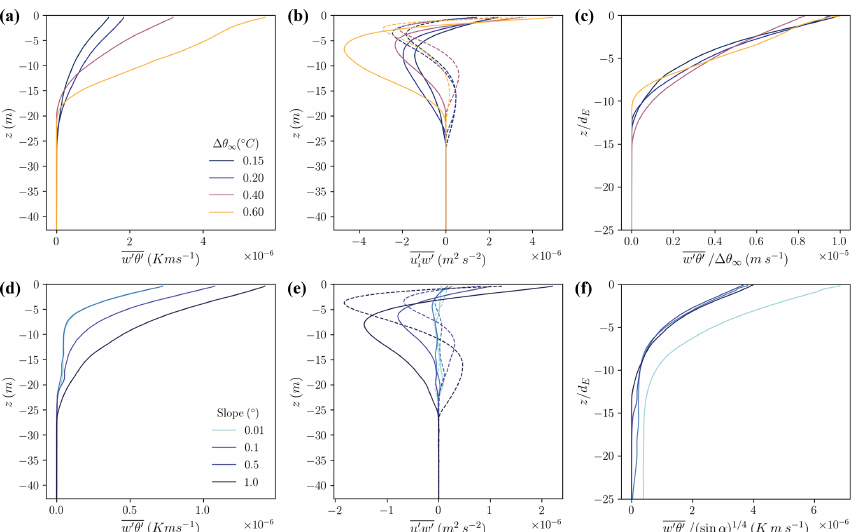
Figure 4. Vertical profiles of (a, c) momentum flux, (b, e) heat flux, and (c, f) scaled heat flux averaged over the last inertial period. The first row shows temperature cases, and the second row shows slope cases. Momentum flux is expressed in two components: u (cid:48) w (cid:48) (dashed) and v (cid:48) w (cid:48) (solid). Positive flux denotes upward flux (i.e., drag). The horizontal axis limits vary between panels.